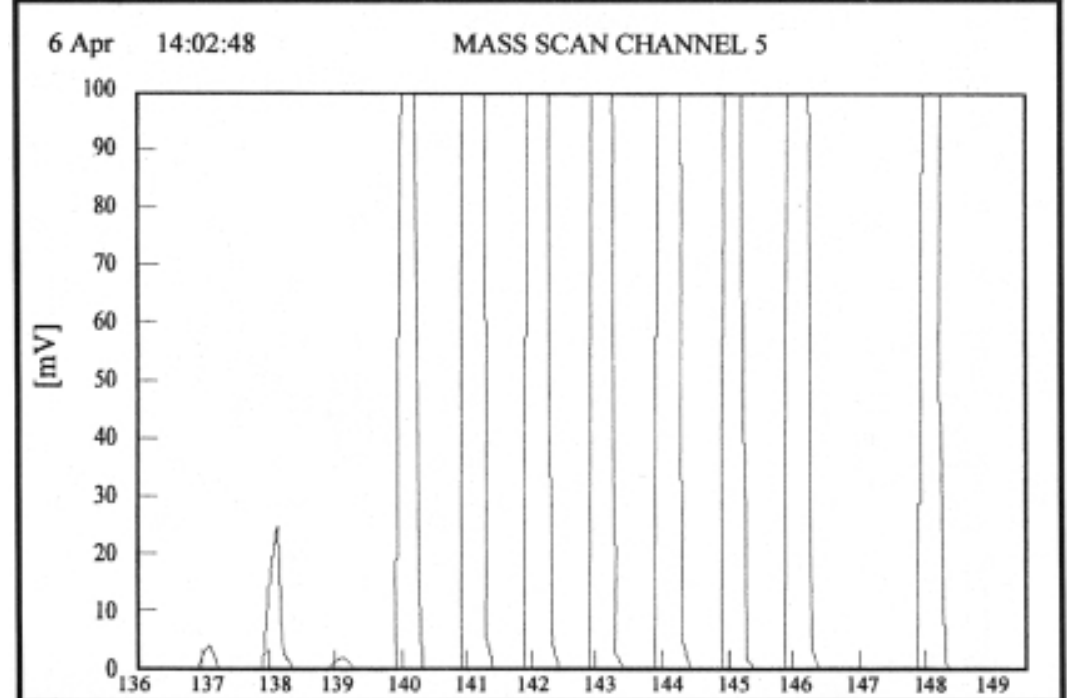
Fig. 8 – Mass interference for Nd. Increased scale, with 2.2 volts for 142